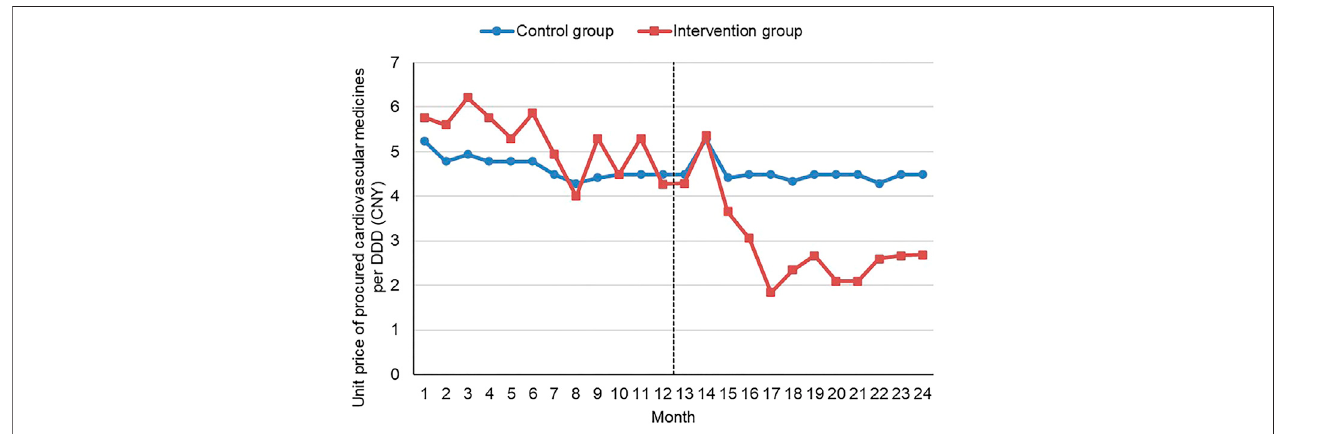
TABLE 4 | Generalized linear regression model on unit price of all procured cardiovascular medicines with difference-in-differences analyses. Variables